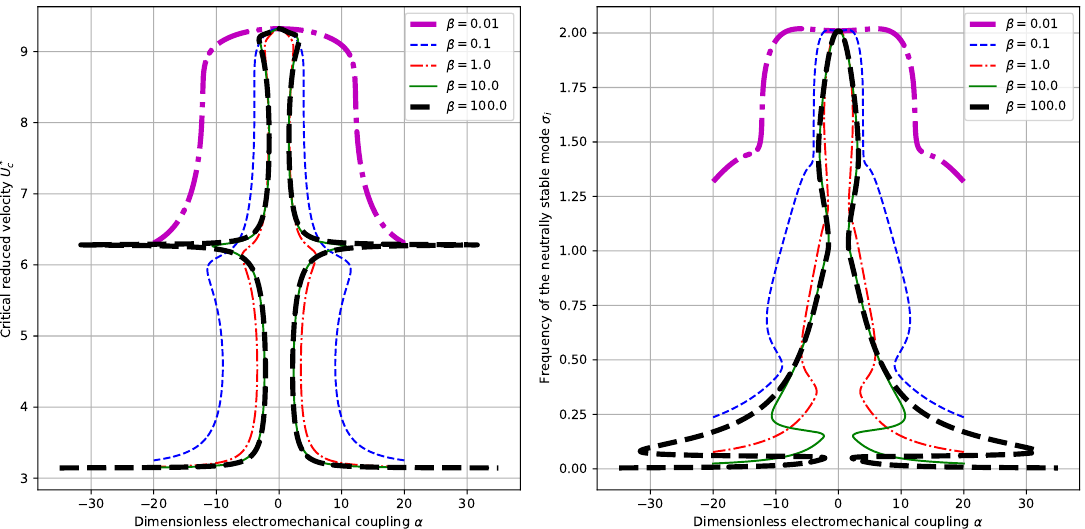
Figure 6. Dependence of the critical reduced velocity U ∗ c ( left panel) and the corresponding neutrally stable frequency σ i ( right panel) upon the electromechanical coupling α and different values of β . (Here we have M ∗ =